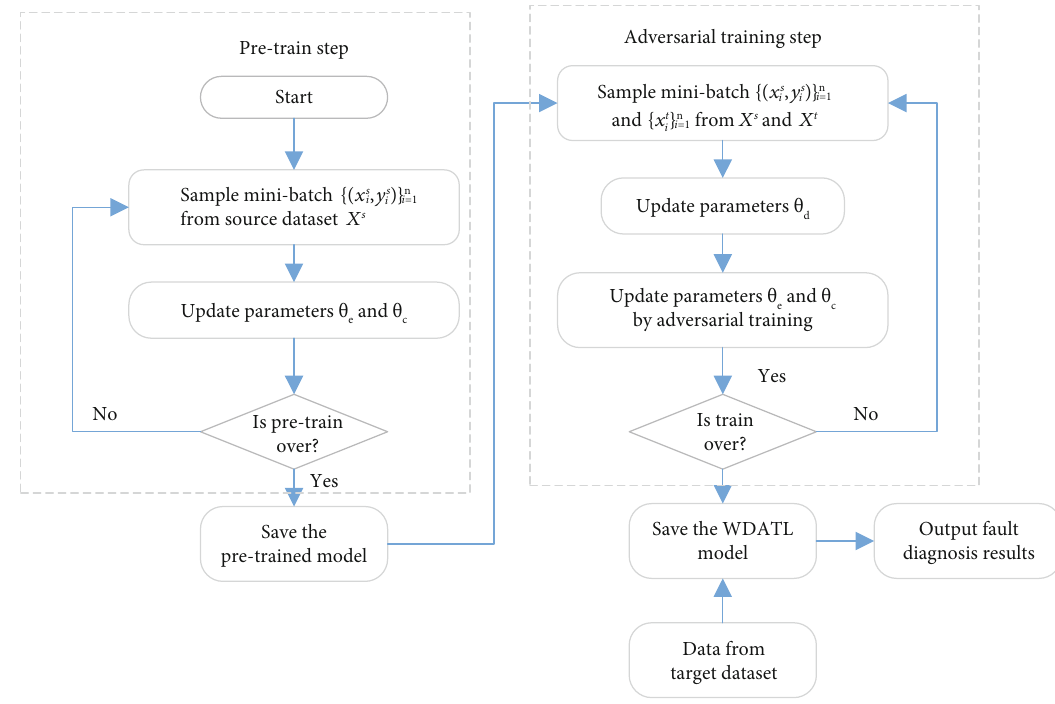
Figure 5: The fl owchart of the proposed